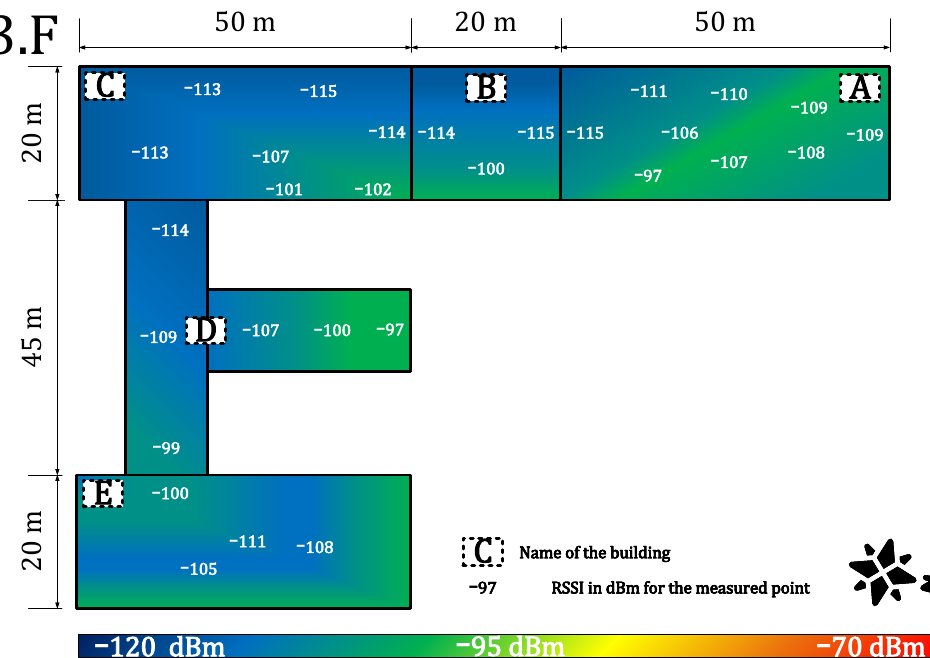
Figure 10. Public network coverage and signal propagation on the fifth floor.